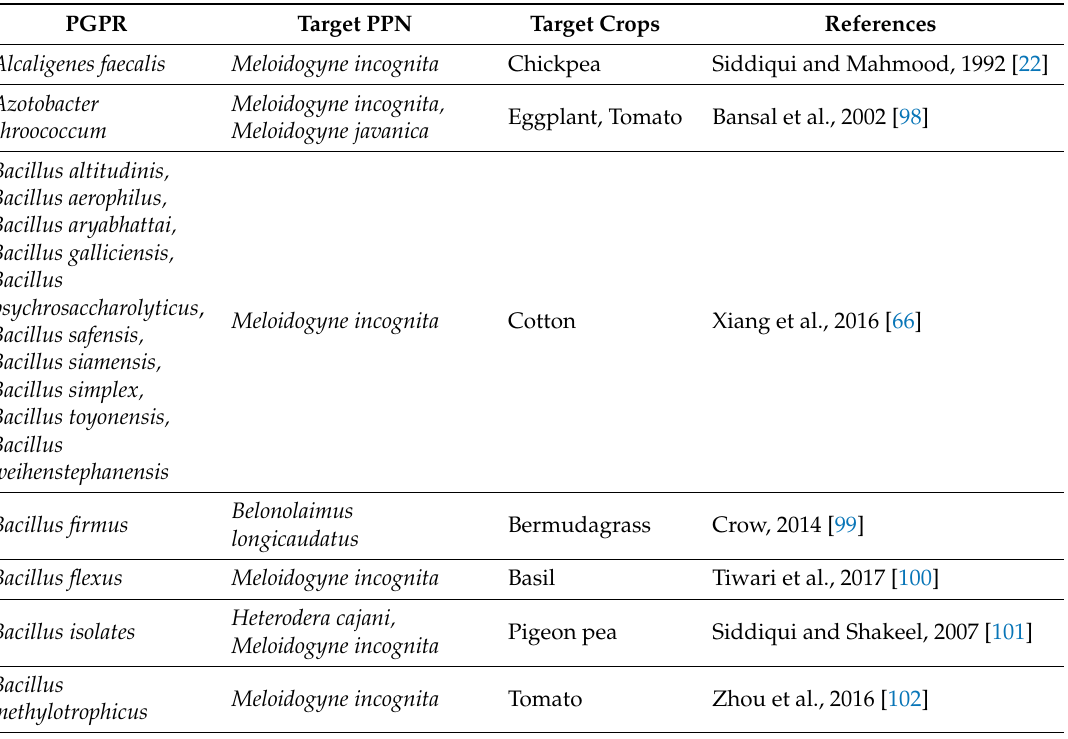
Table 4. A list of PPN inhibitory PGPR with uncharacterized